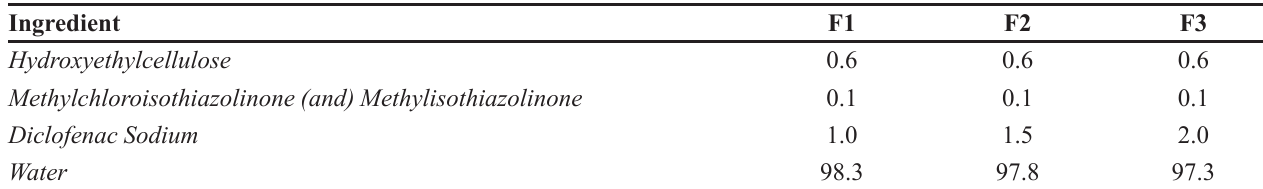
TABLE I - Composition of formulations (%, w/w) evaluated Ingredient Hydroxyethylcellulose